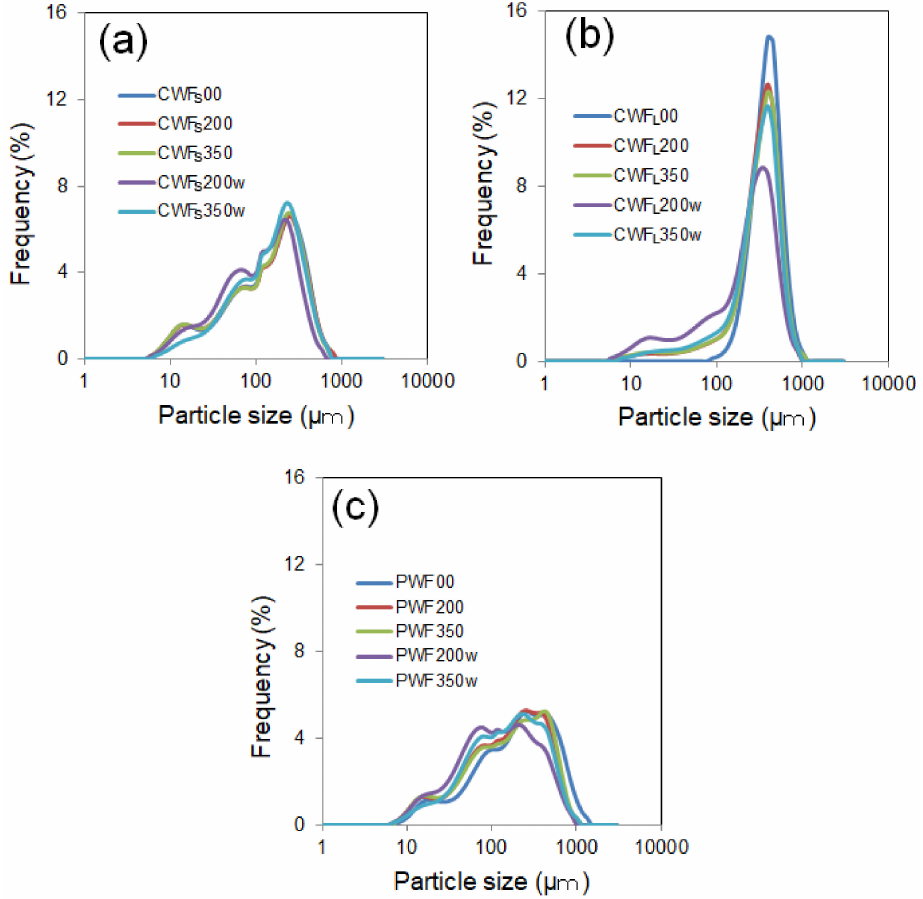
Figure 1. Wood particle size distribution curves of initial (00), dry pulverized at mill-plate gap 200 µ m (200), dry pulverized at mill-plate gap 350 µ m (350), wet pulverized at mill-plate gap 200 µ m (200w), and wet pulverized at mill-plate gap 350 µ m (350w) respectively, of ( a ) short cypress flour (CWF S ), ( b ) long cypress flour (CWF L ), and ( c ) pine flour